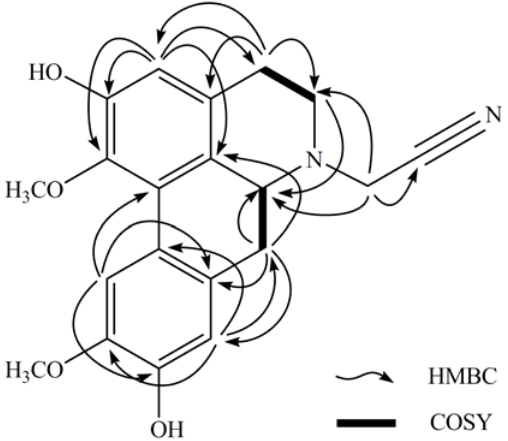
Figure 6. Selected 2D NMR correlations of N -cyanomethylnorboldine ( 1